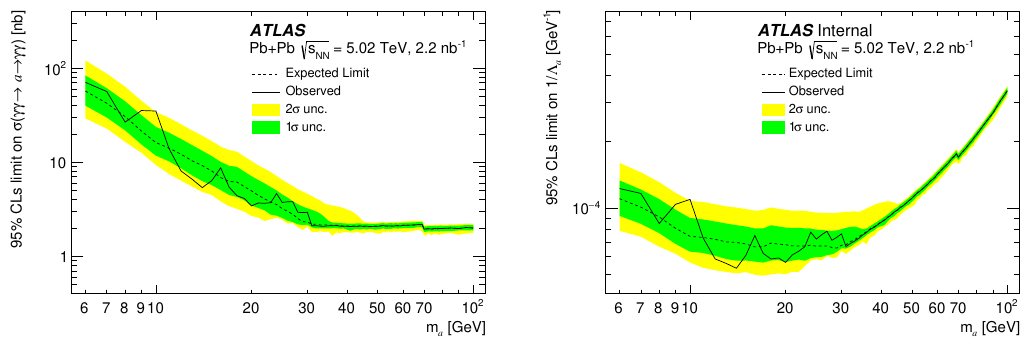
Figure 9 . The 95% CL upper limit on the ALP cross section σ γγ → a → γγ (left) and ALP coupling 1 / Λ a (right) for the γγ → a → γγ process as a function of ALP mass m a . The observed upper limit is shown as a solid black line and the expected upper limit is shown by the dashed black line with its ± 1 and ± 2 standard deviation bands. The discontinuity at m a = 70 GeV is caused by the increase of the mass-bin width which brings an increase in signal